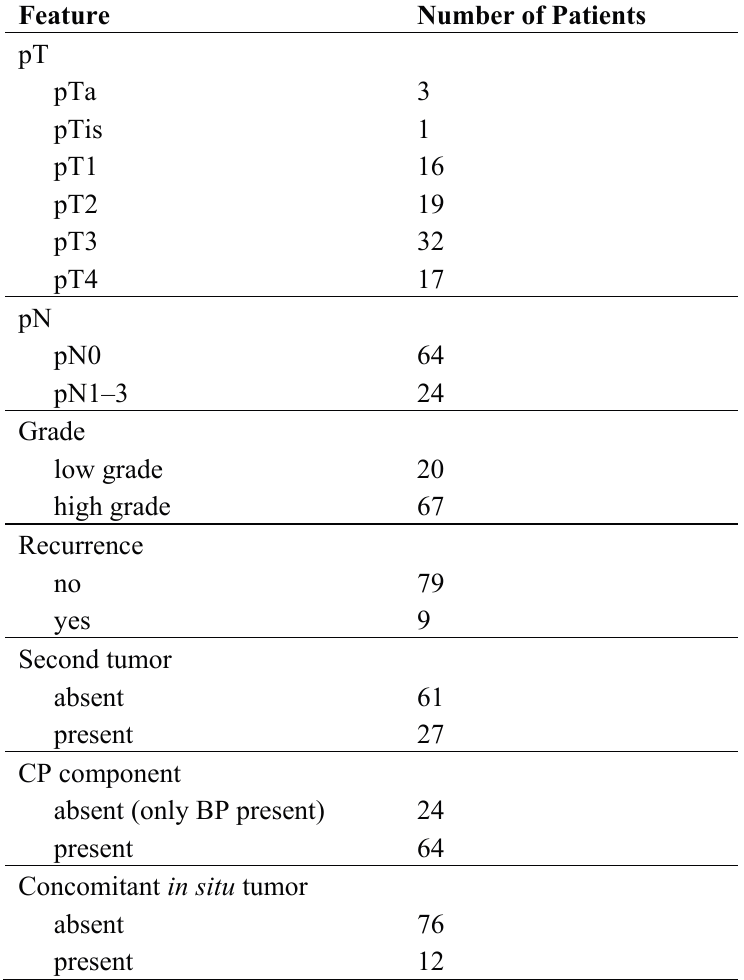
Table 2. The clinical–pathomorphological characteristic of urothelial bladder tumors.